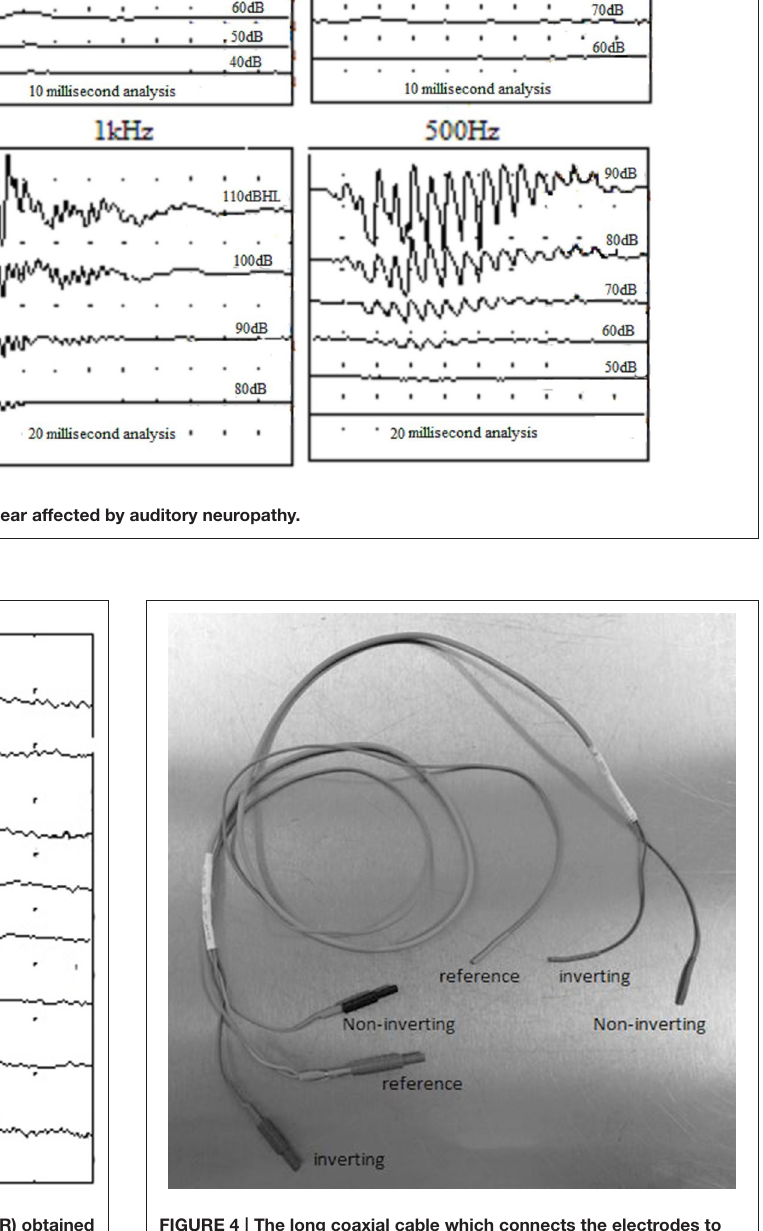
Frontiers in Neuroscience | www.frontiersin.org